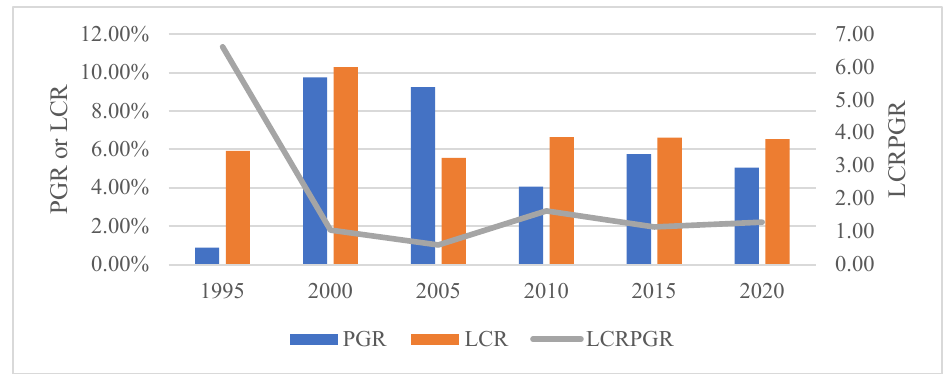
Figure 7. Curve of LCRPGR in Nanning.